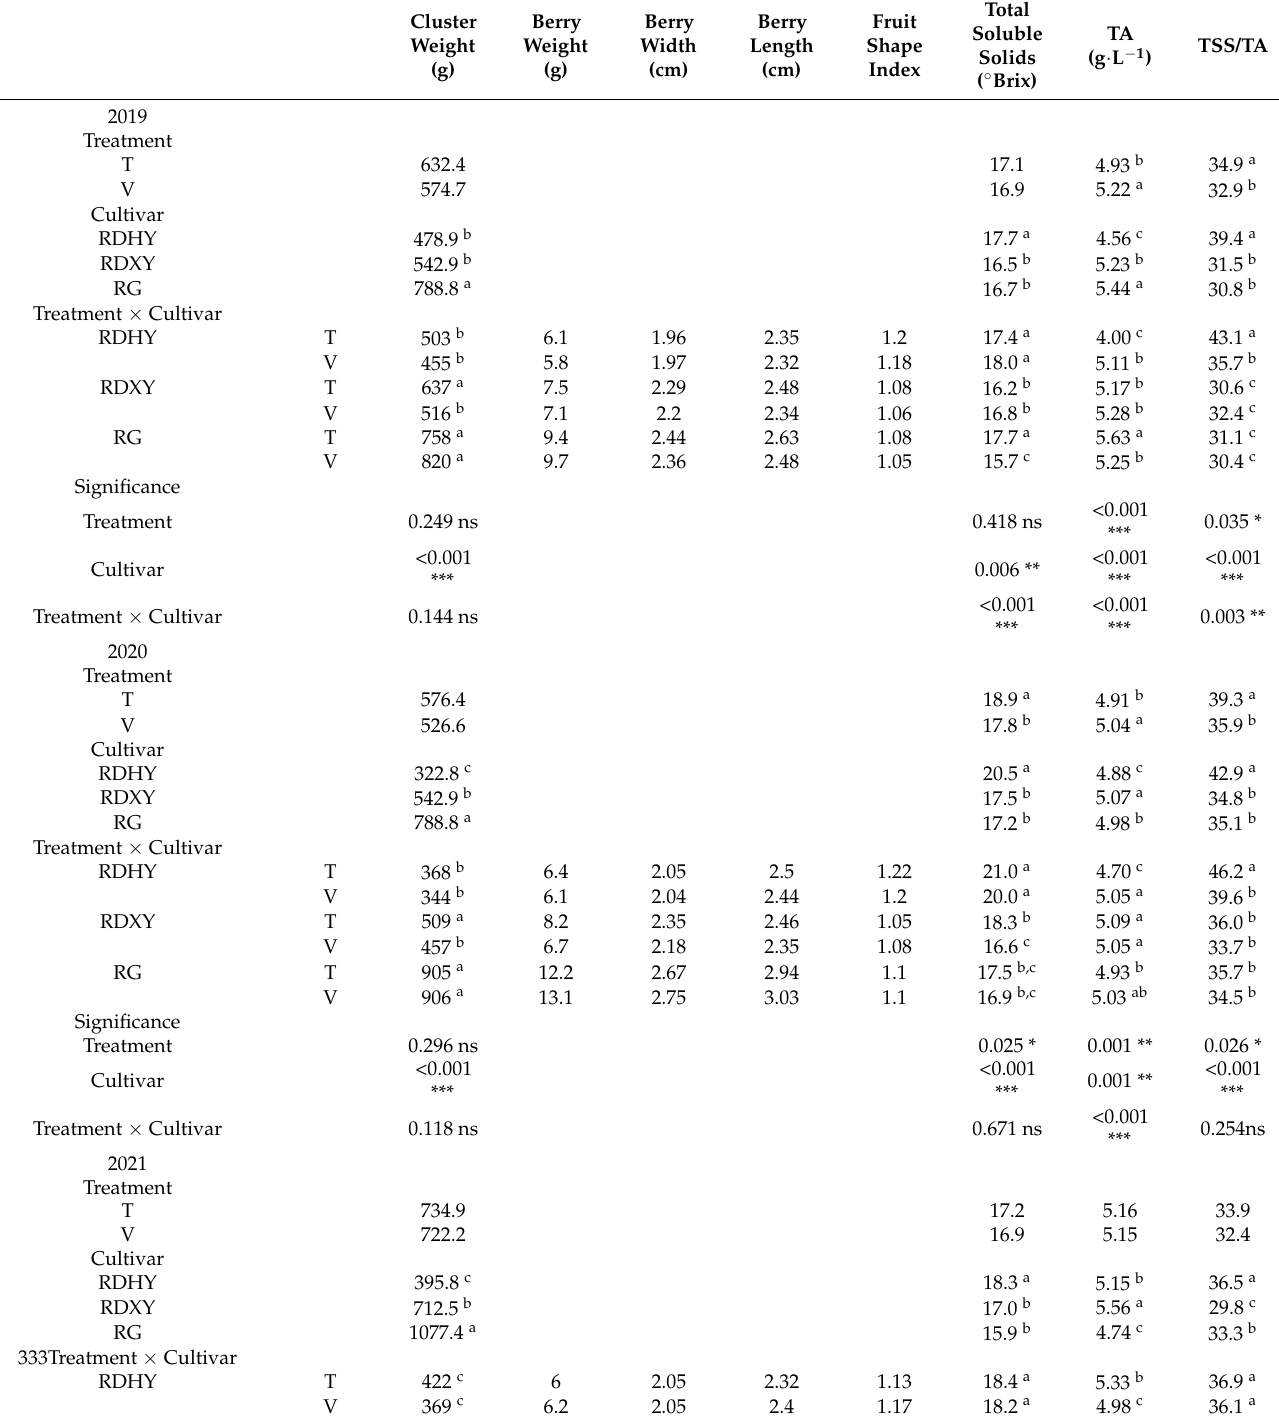
Table 3. Fruit physicochemical indicators of the three cultivars under two trellis systems. Data are the mean of three replications. A two-way analysis of variance (ANOVA) was conducted (treatment × cultivar). Within the same column and factor, different letters stand for a significant difference ( p value < 0.05) according to the Student–Newman–Keuls test. Significant differences are indicated: *, p value < 0.05; **, p value < 0.01, ***, p value < 0.001, ns, not